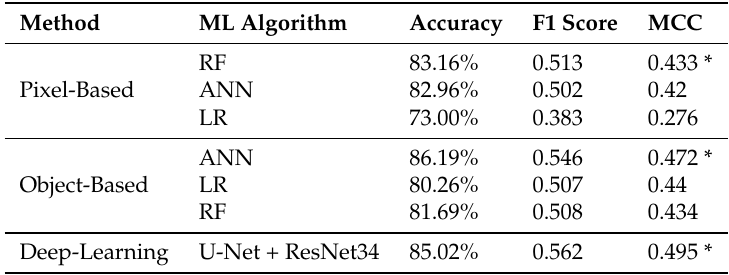
Table 4. Accuracy assessment of Machine Learning Algorithms.